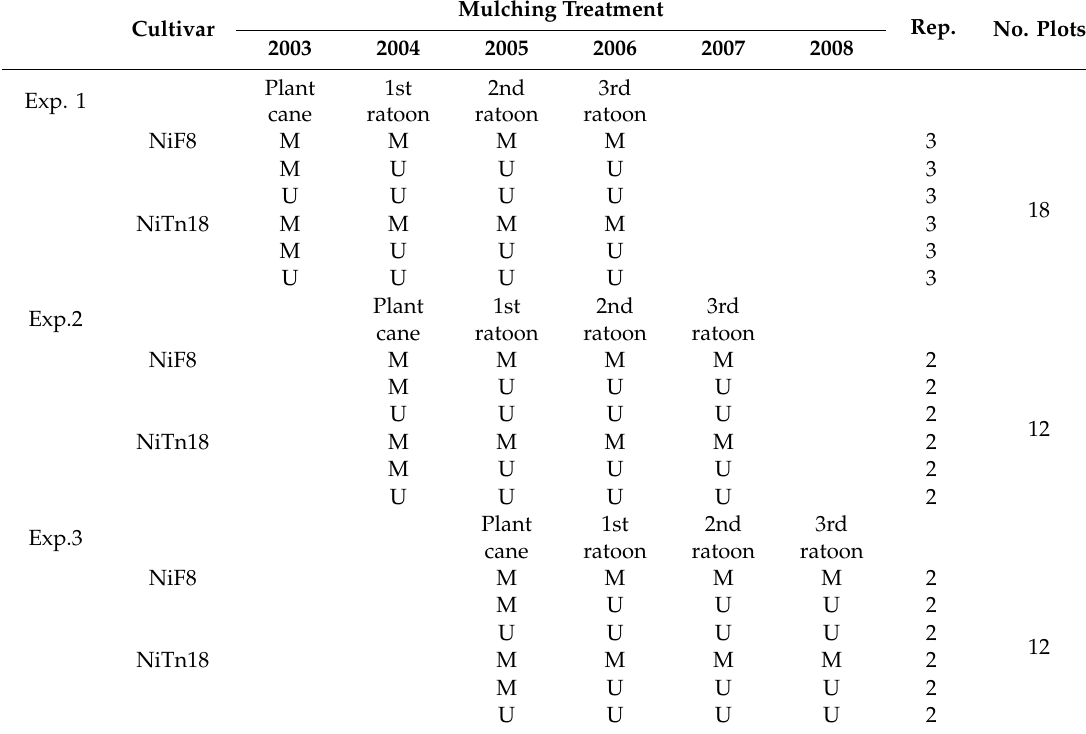
Table A1. Detailed description of field experiments (Exp.).